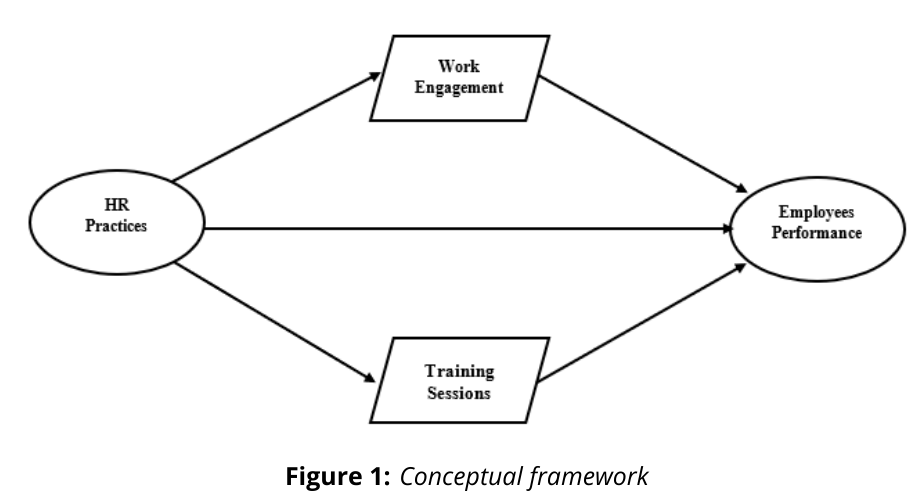
Figure 1: Conceptual